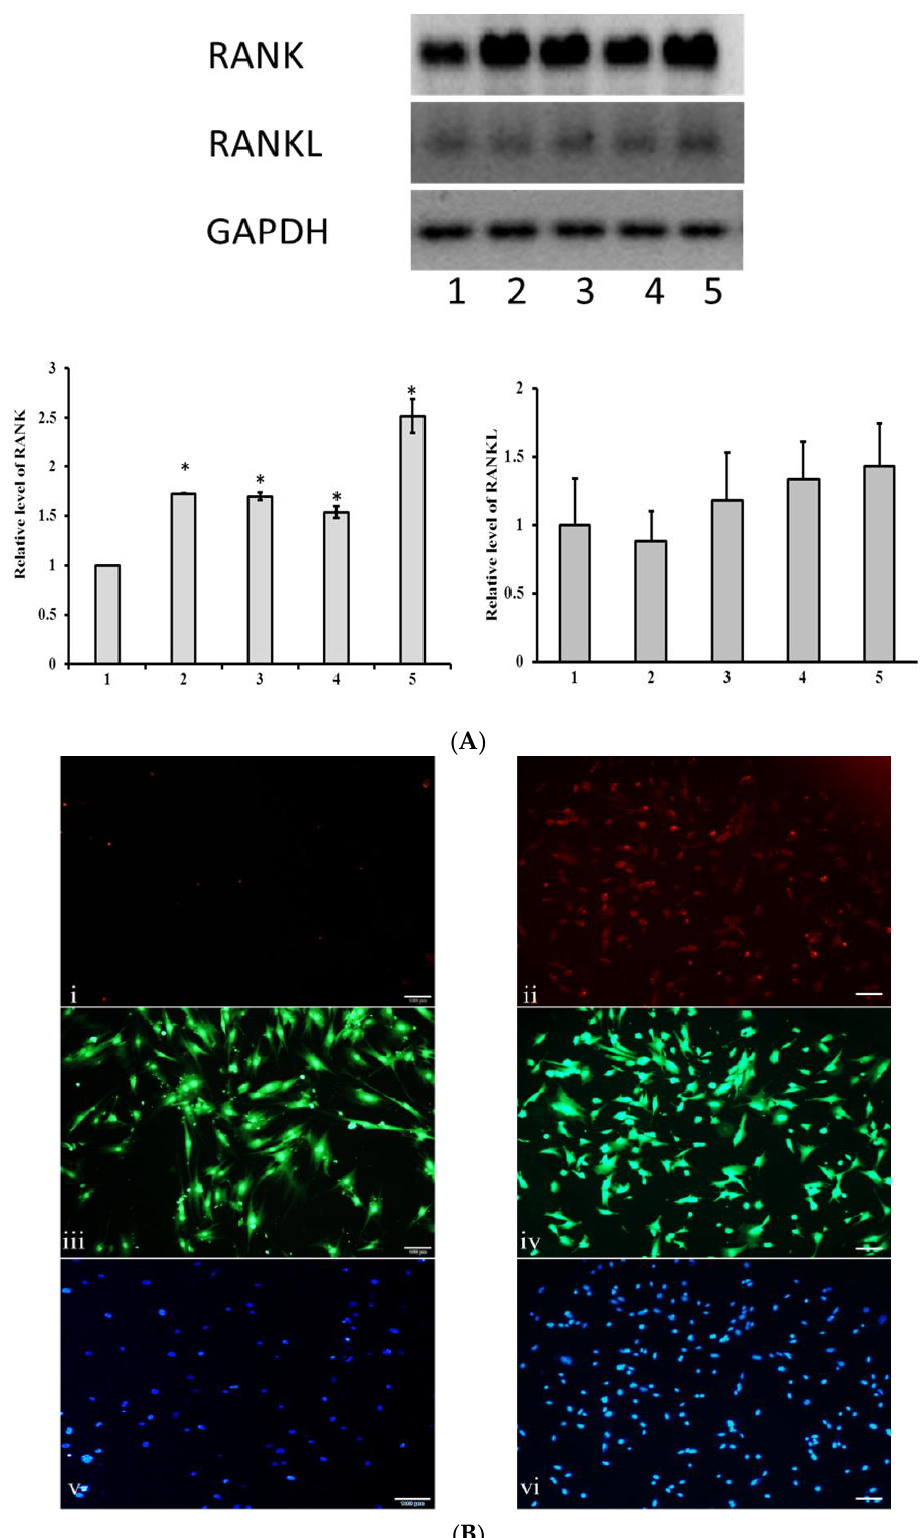
Figure 5. RANK expression of MSCs treated with sRANKL and PTHrP. ( A ) Western blot analysis, 1 — control, 2 — sRANKL50 (50 ng/mL), 3 — PTHrP50 (50 nM/mL), 4 — sRANKL10 – PTHrP10 (10 ng/mL + 10 nM/mL), 5 — sRANKL50 – PTHrP50 (50 ng/mL + 50 nM), * p < 0.05 vs. control. ( B ) Immunocytochemistry, (i,ii), (iii,iv) and (v,vi): RANK expression, fluorescein isothiocyanate (FITC) and 4 ′ ,6-diamidino-2-phenylindole (DAPI) staining of control and sRANKL treated cells, respectively.